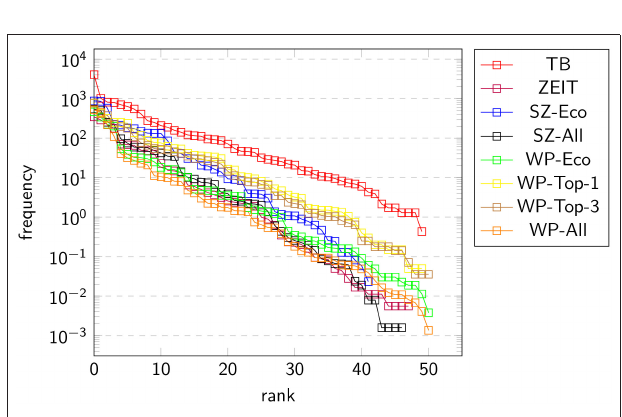
FIGURE 4 | Rank-specificity distribution of threshold concepts based on compounding